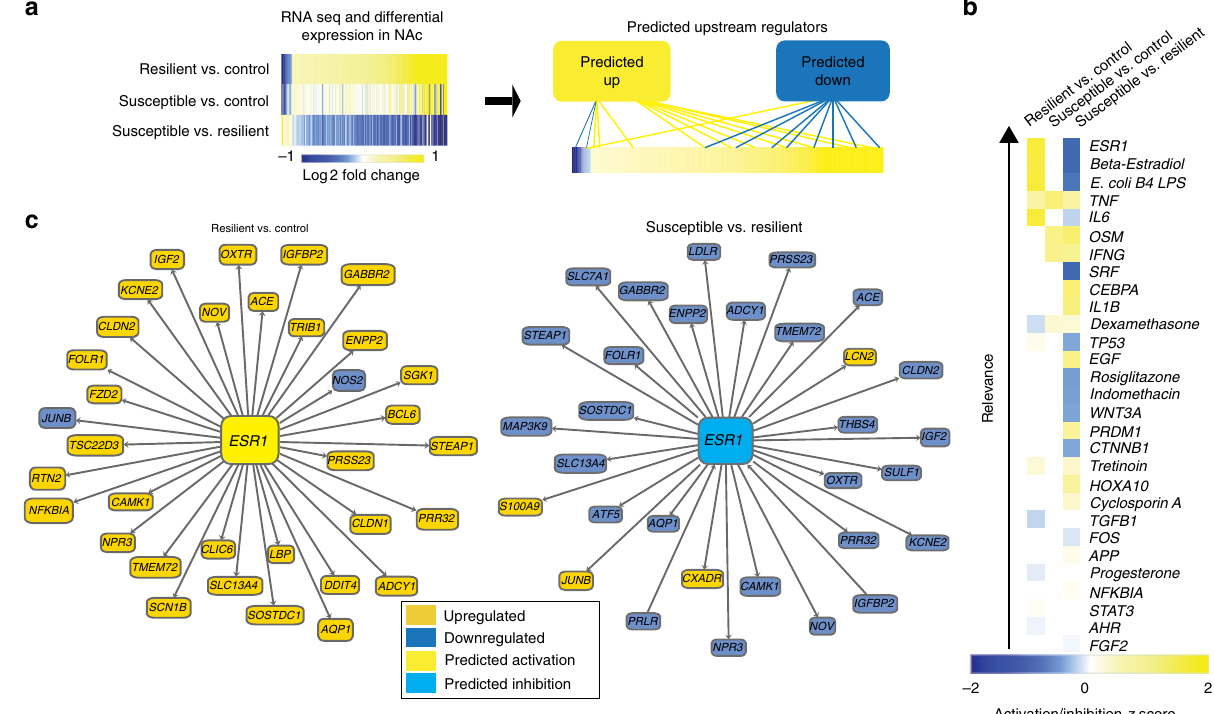
Fig. 1 ER α is a predicted upstream regulator of pro-resilient transcriptional changes in NAc. a Experimental overview of upstream regulator analysis. NAc genes differentially expressed in control, CSDS susceptible, and CSDS resilient mice 48 h post defeat were used to predict upstream regulators. b Findings from IPA upstream regulator analysis on differentially expressed genes in CSDS. ESR1 , which encodes ER α , is the top-predicted upstream regulator of differentially expressed genes (log fold change >1; P < 0.05) in the resilient vs. control (predicted activation; z -score = 3.16; P < 6.64 × 10 − 6 ) and susceptible vs. resilient (predicted inhibition; z -score = 3.22; P < 1.38 × 10 − 8 ) comparisons, with no predicted upstream regulator activity in susceptible vs. control. c Known interactions of differentially expressed genes (log fold change > 1) in the resilient vs. control and susceptible vs. resilient comparisons giving rise to the prediction of ESR1 as an upstream